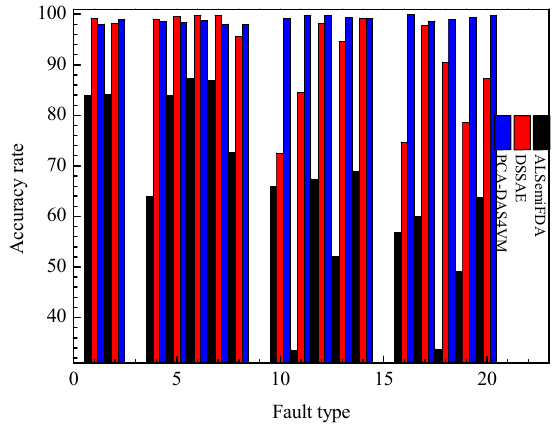
Figure 13. Accuracy rate for dynamic sparse stacked auto-encoders (DSSAE), ALSemiFDA, and PCA- DAS4VM models.